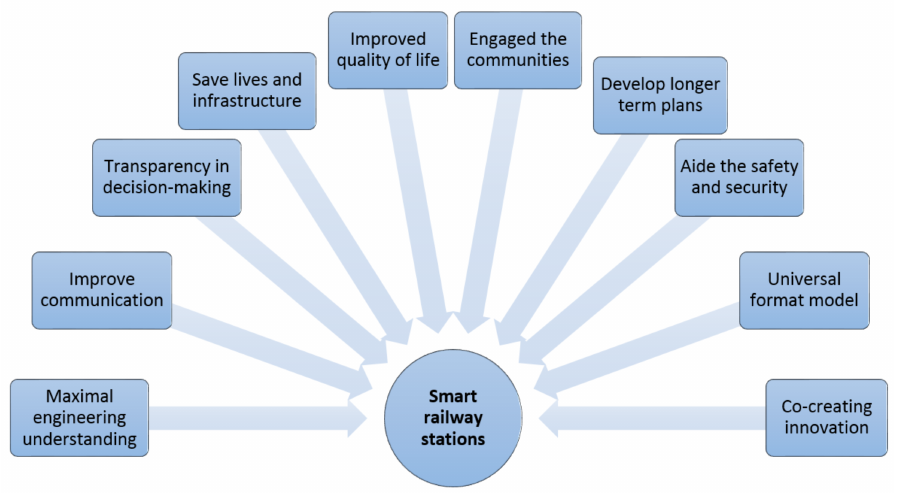
Figure 7. Potential benefit of the smart city concept model (SCCM) in railway stations (British Standards institution (BSI))